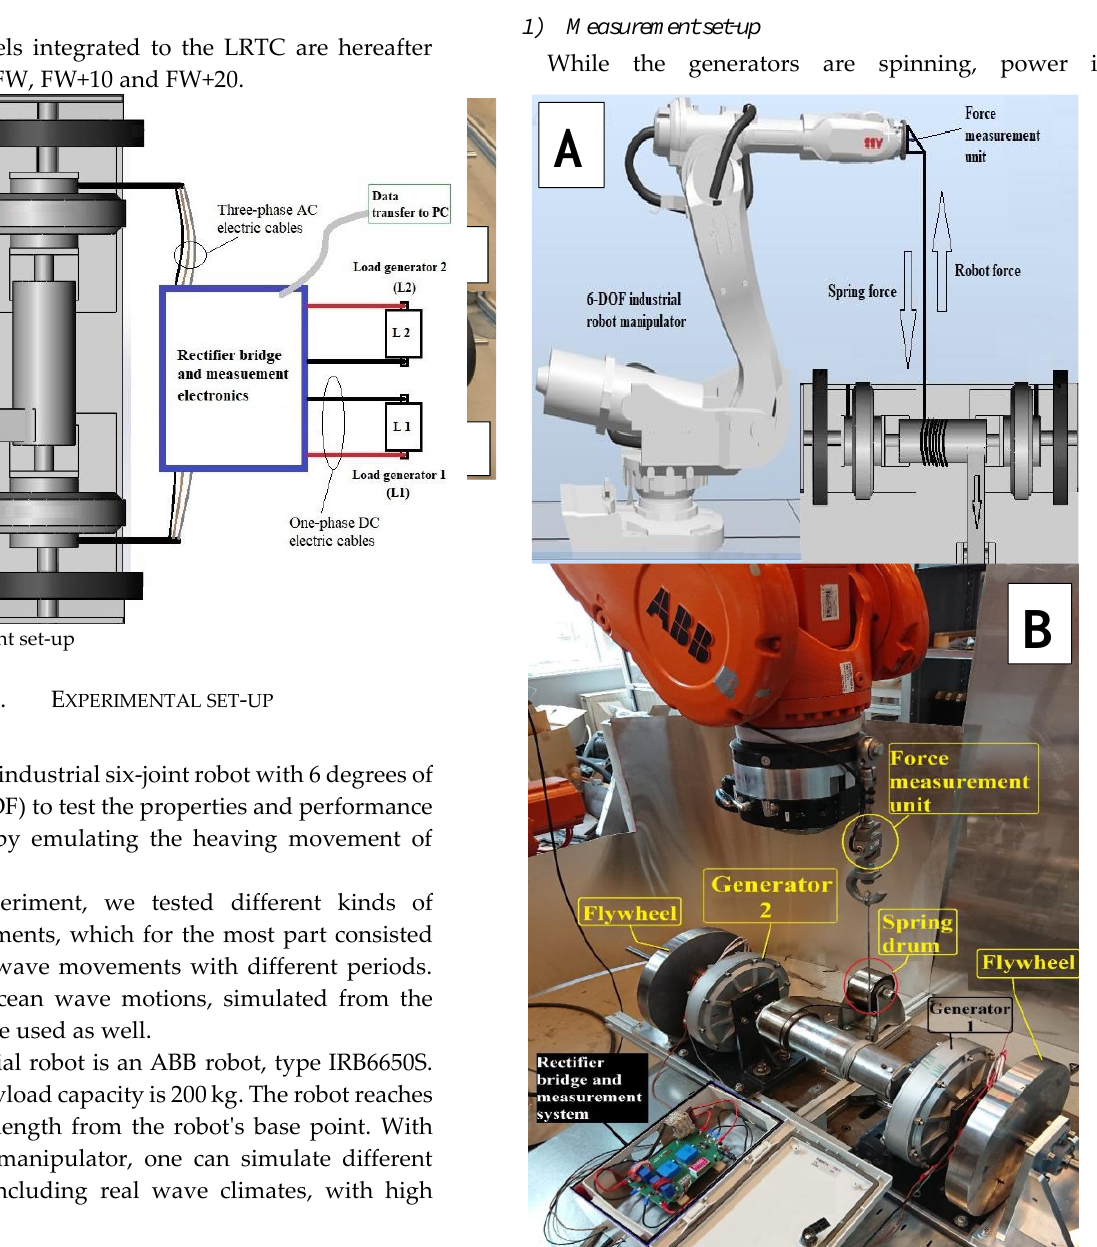
Fig. 6. Experimental set-up